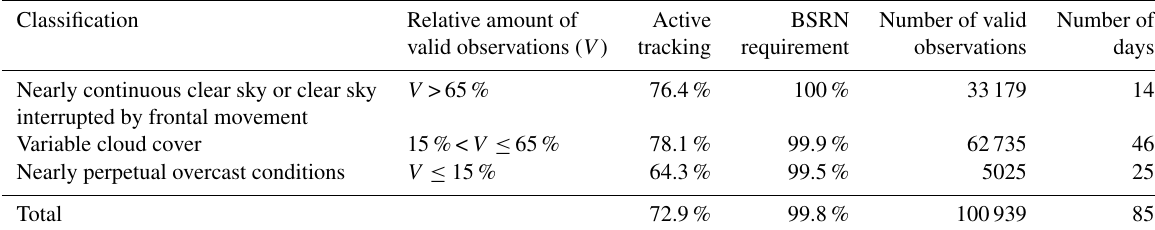
Table 2. Summary of the achieved tracking accuracy for the determined sky-cover categories. Classification Relative amount of Active BSRN Number of valid Number of valid observations ( V ) tracking requirement observations days Nearly continuous clear sky or clear sky V >65% 76.4% 100% 33179 14 interrupted by frontal movement Variable cloud cover 15%< V ≤ 65% 78.1% 99.9% 62735 46 Nearly perpetual overcast conditions V ≤ 15% 64.3% Total 72.9%